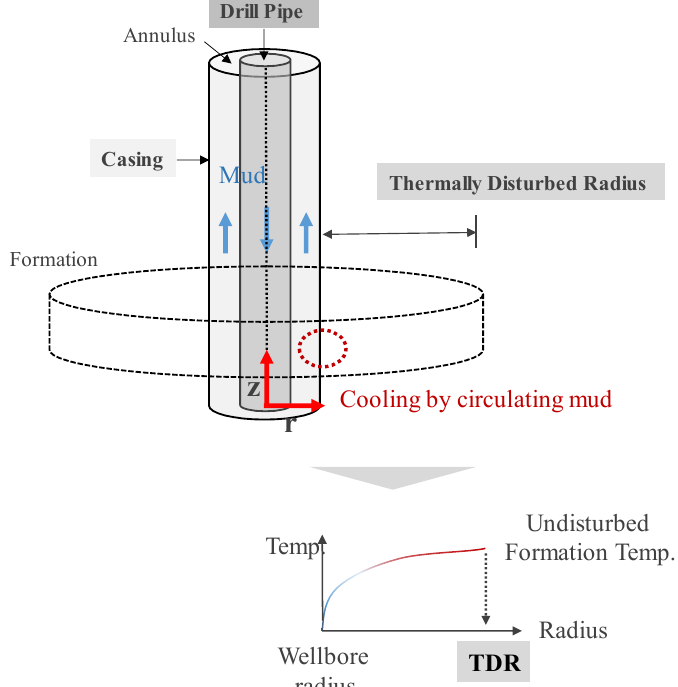
Figure 1. Schematic diagram of cooling effect by the circulating mud during drilling.